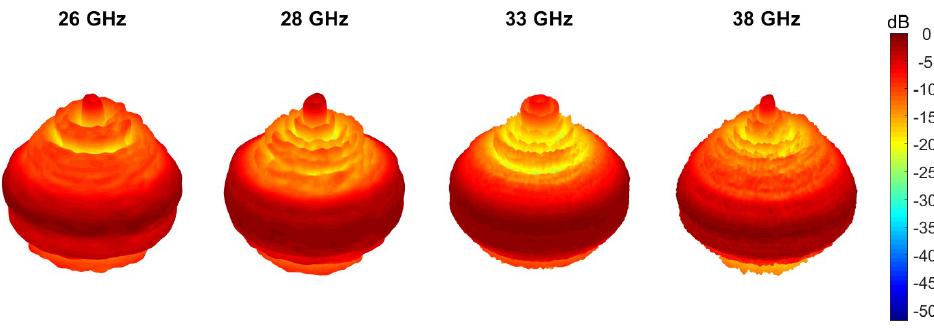
Figure 2. Radiation pattern of the Tx antenna measured at 26 GHz, 28 GHz, 33 GHz and 38